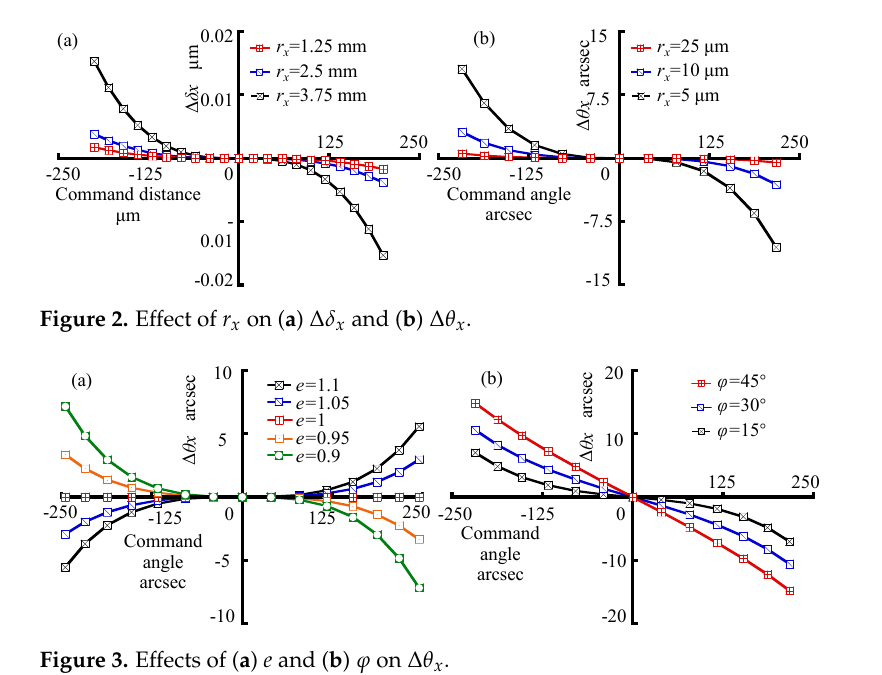
Figure 3. Effects of ( a ) e and ( b ) φ on Δ θ x .